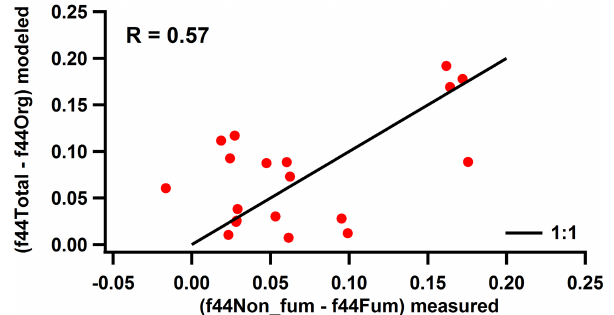
Figure 8. Scatterplot between the calculated (cid:49)f 44 and the mea- sured (cid:49)f 44 coming from